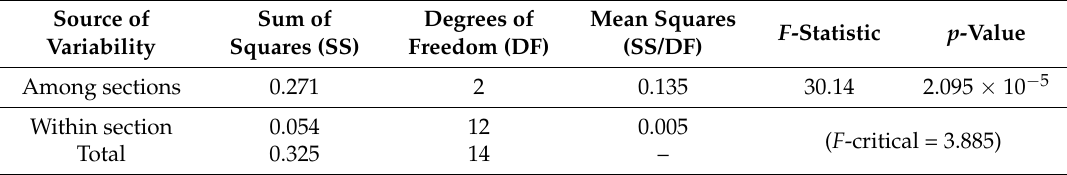
Figure 5. Pavement 3D mean macrotexture depth of tested sections.